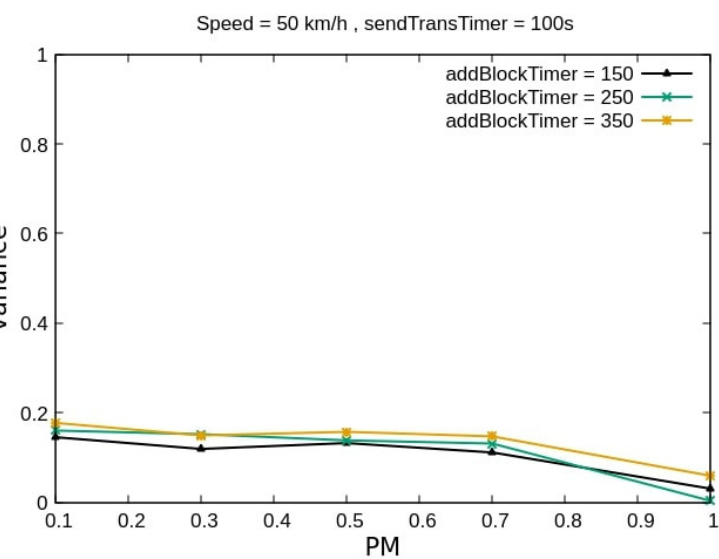
Figure 10 . The variance of the trust metrics for malicious vehicles vs. PM, sendTransTimer = 100 s .